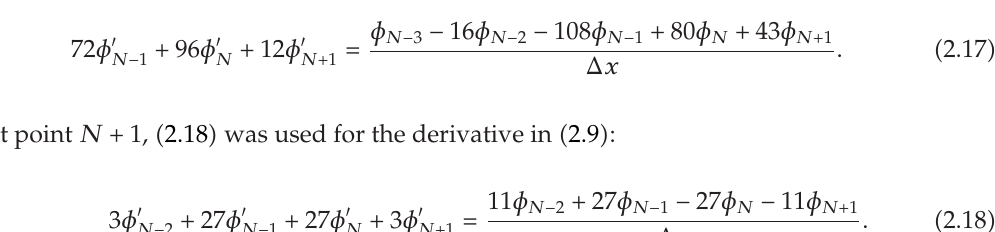
At point N , (cid:6) 2.17 (cid:7) was used for the derivatives in (cid:6) 2.9 (cid:7) and (cid:6) 2.10 (cid:7) :